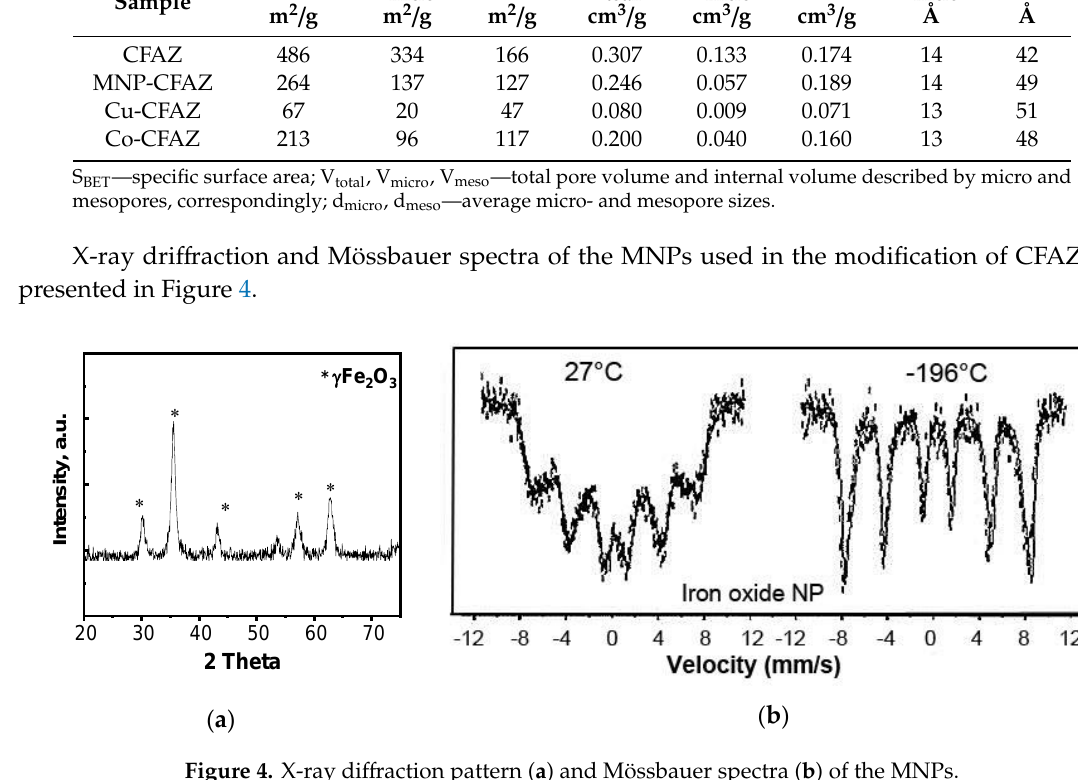
Table 2. Mössbauer parameters of the iron oxide nanoparticles.